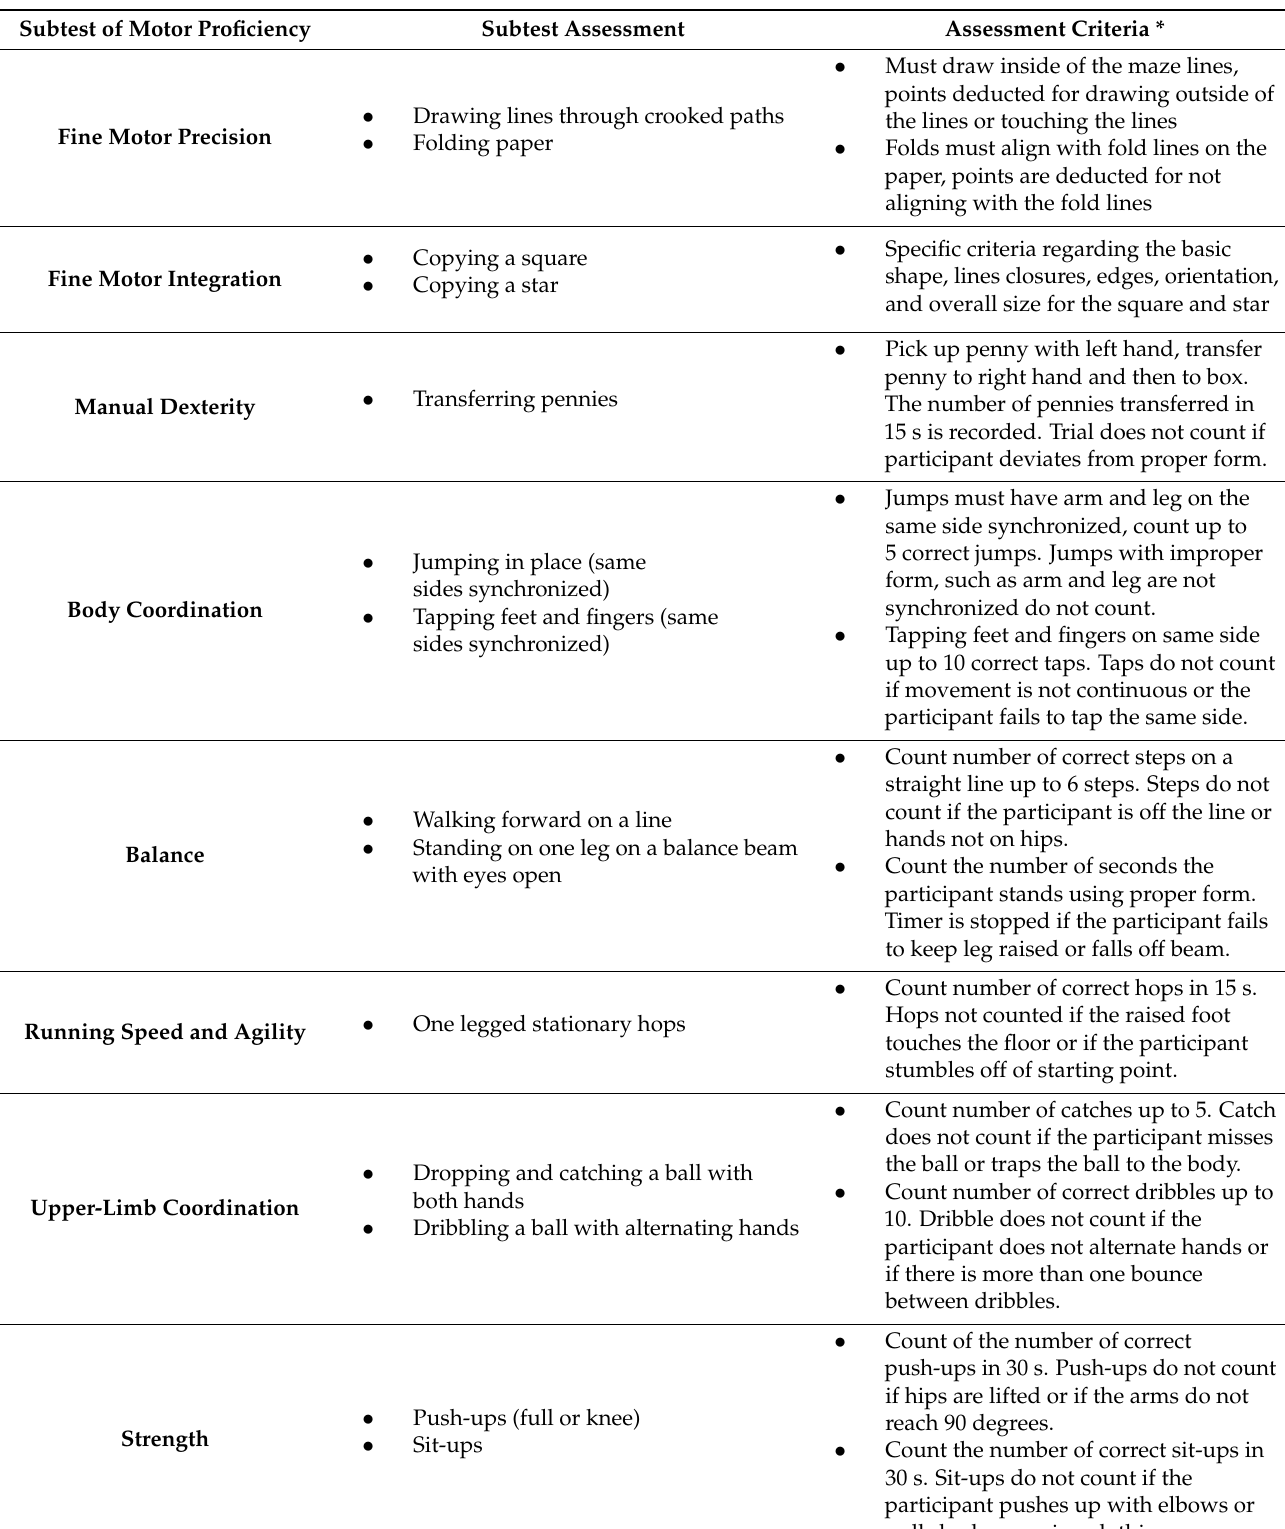
Table 1. Assessments Included in Each Subtest of the Bruininks–Oseretsky Test of Motor Proficiency–2 Short Form (BOT-2